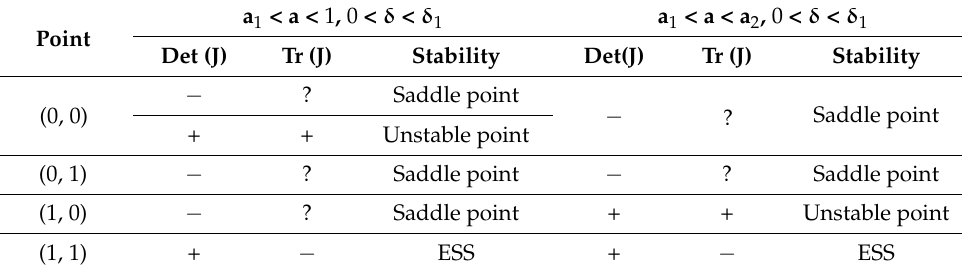
Table 11. Stability analysis of the points in case